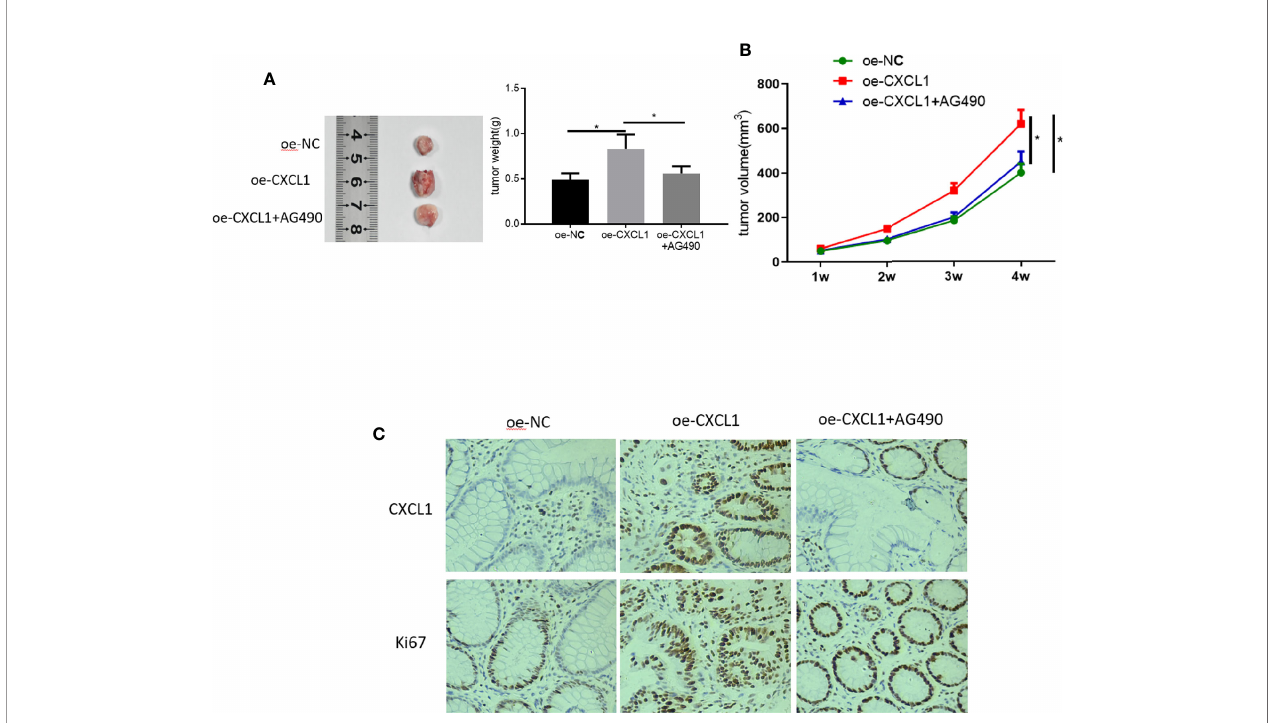
FIGURE 7 | CXCL1 promotes CRC proliferation in vivo via JAK-STAT signaling pathway. SW480 cells transfected with oe-NC, oe-CXCL1 and oe-CXCL1+AG490 were subcutaneously grafted into nude mice, respectively. (A) Tumor size and tumor weight after 4 weeks, (B) tumor volume in the fi rst 4 weeks, (C) immunohistochemistry showed the levels of CXCL1 and Ki67 in cells (* p <